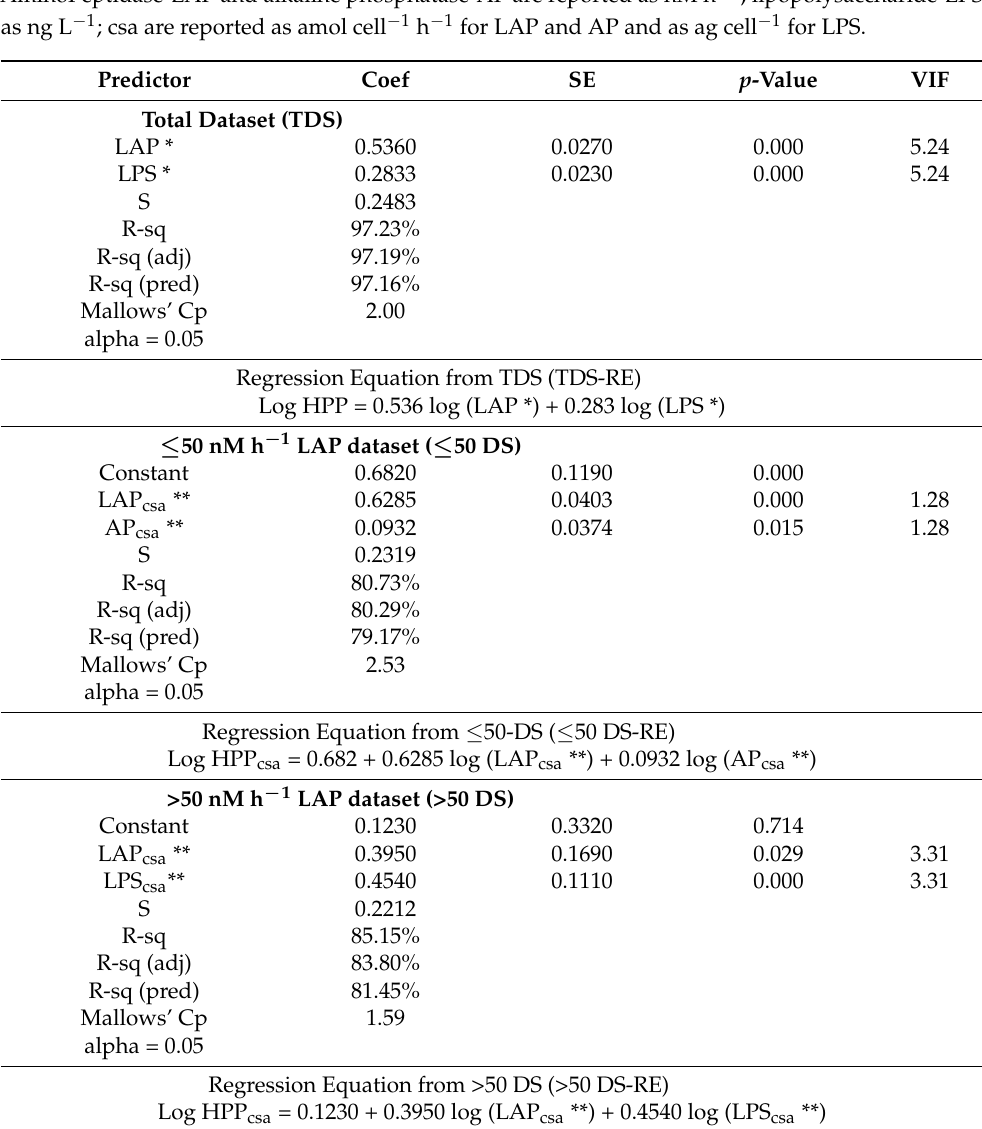
Table 4. Heterotrophic prokaryotic production (HPP) prediction from logarithmic-transformed LAP and LPS variables: selected multiple regression analysis with optimized response from total, ≤ 50 nM h − 1 and >50 nM h − 1 LAP datasets. Abbreviations: SE (standard error of coefficient), VIF (variance inflation factor), TDS (total dataset), RE (regression equation). For the selection of predictor parameters see Table 1, and for the meaning of the regression parameters see Materials and